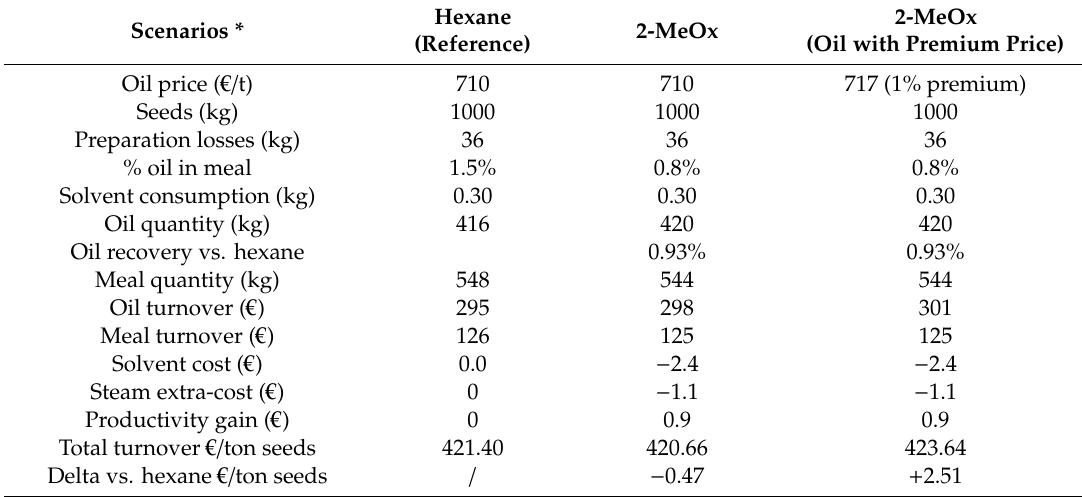
Table 10. Turnover estimations for rapeseed oil extraction with standard residual oil observed in the